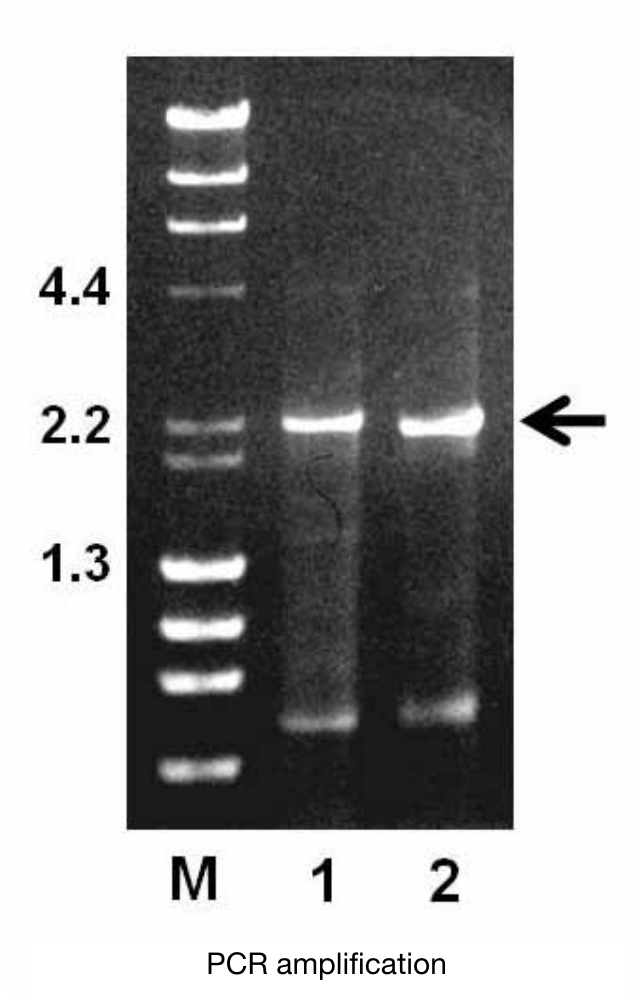
Fig. 2 - PCR products (arrow) of DNA fragments containing intron 19 and exon 20 of PolA1 gene in the Cerasus species, 1: Prunus lannesiana var. speciosa , 2: P. pendula f. ascedens , M: marker